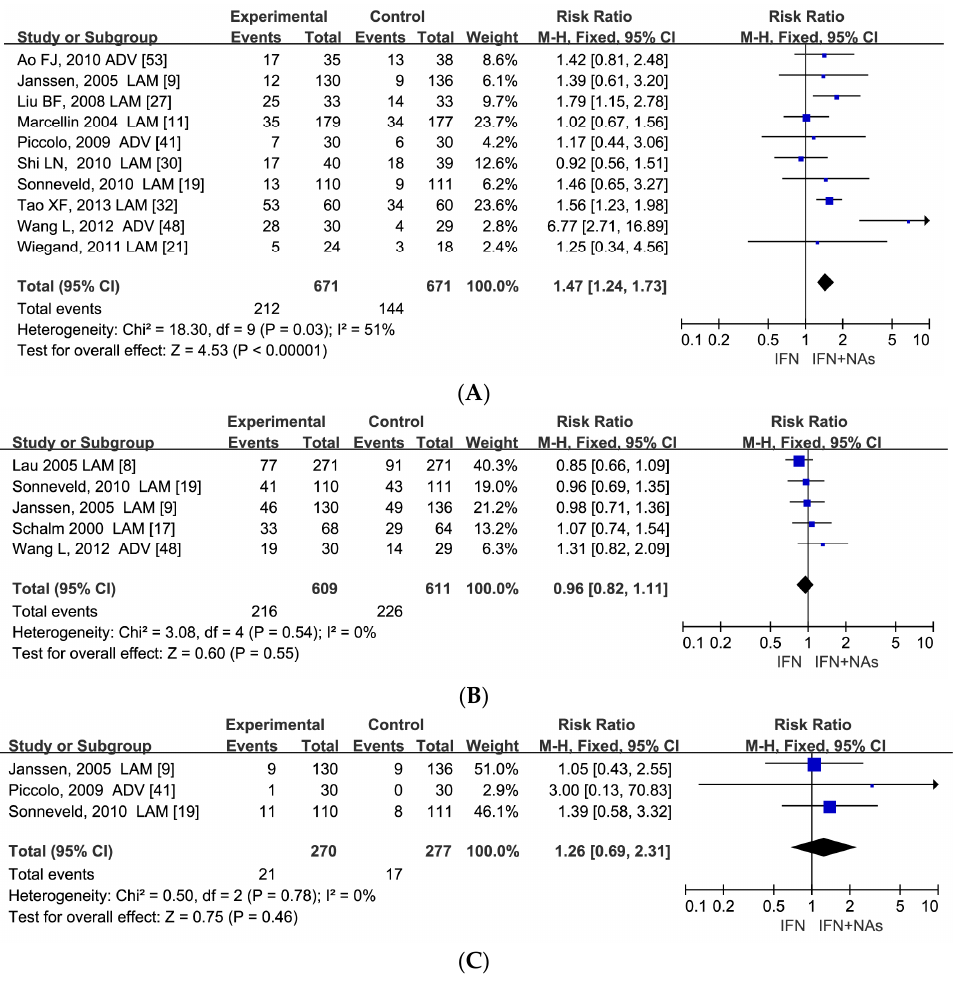
Figure 4. Forest plots of 10 studies including 1342 patients in HBV DNA undetectable rate (RR = 1.47,